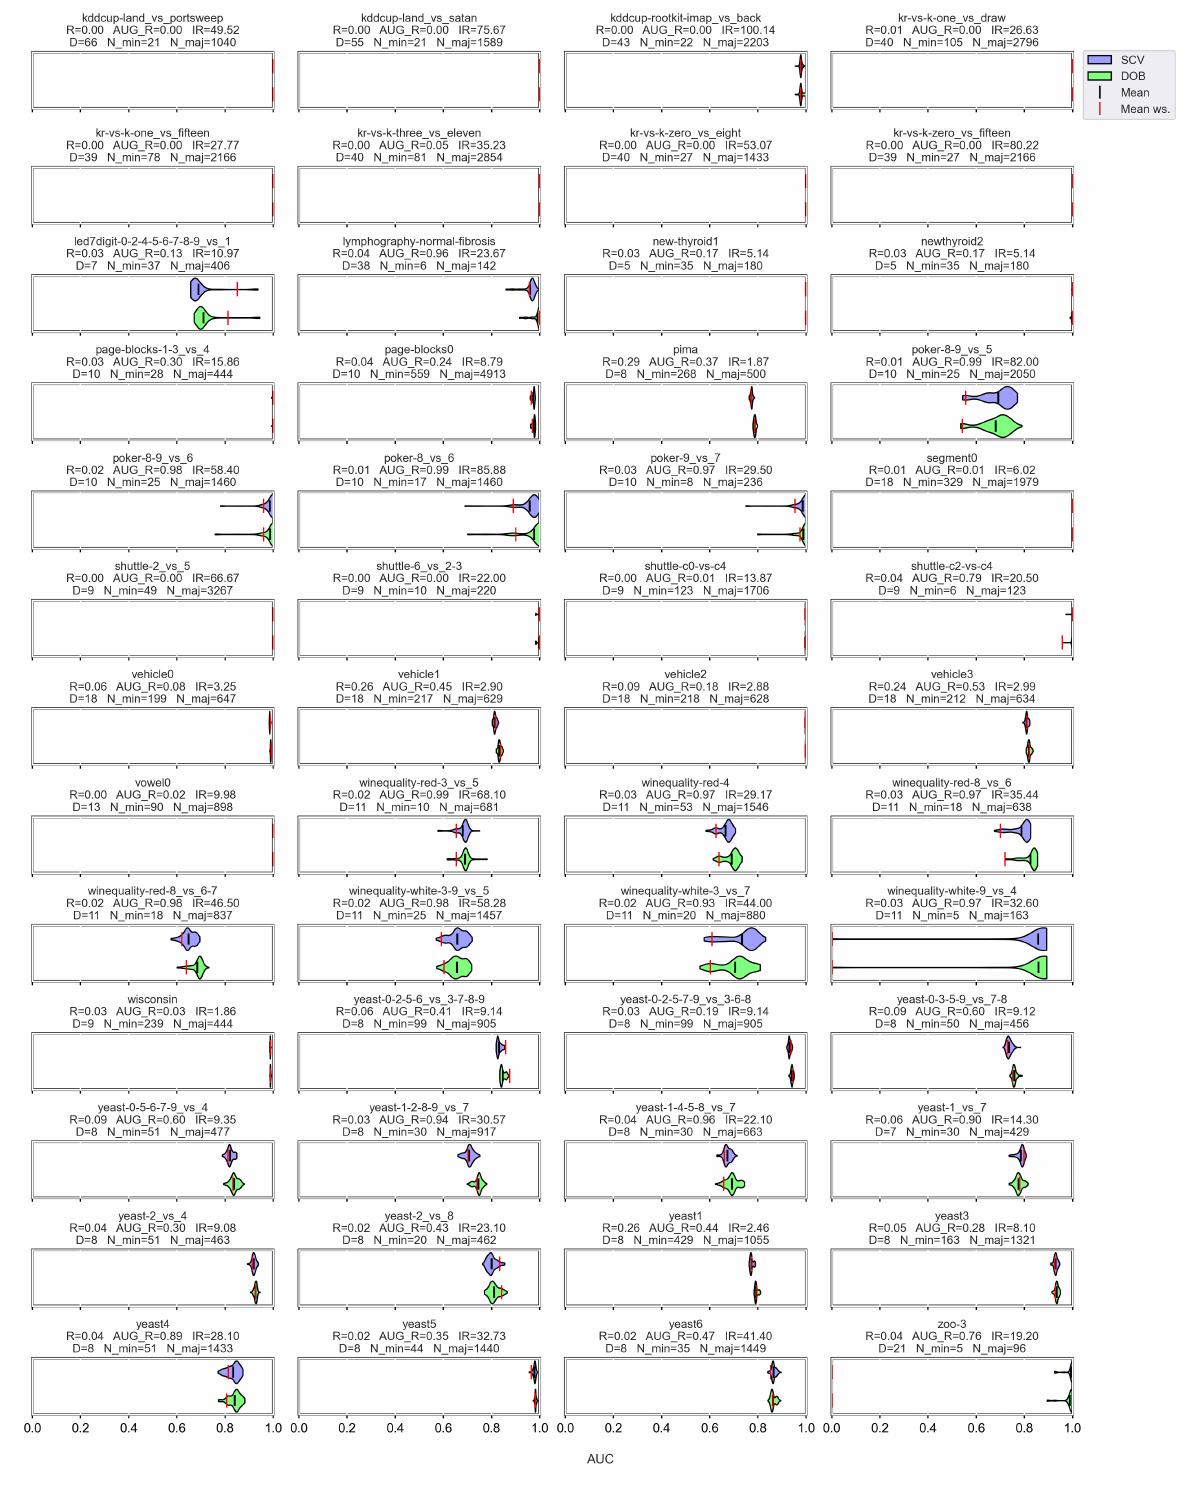
Figure A6. AUC values resulted by the kNN classifier and the named oversamplers per data set of